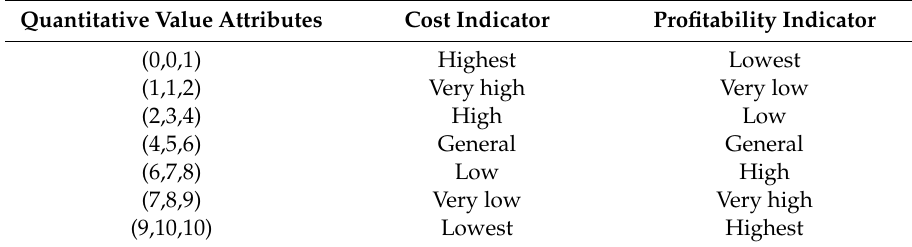
Table 5. Triangular fuzzy number ratio method for transforming qualitative index into quantitative